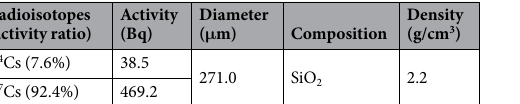
Radioisotopes (activity ratio)